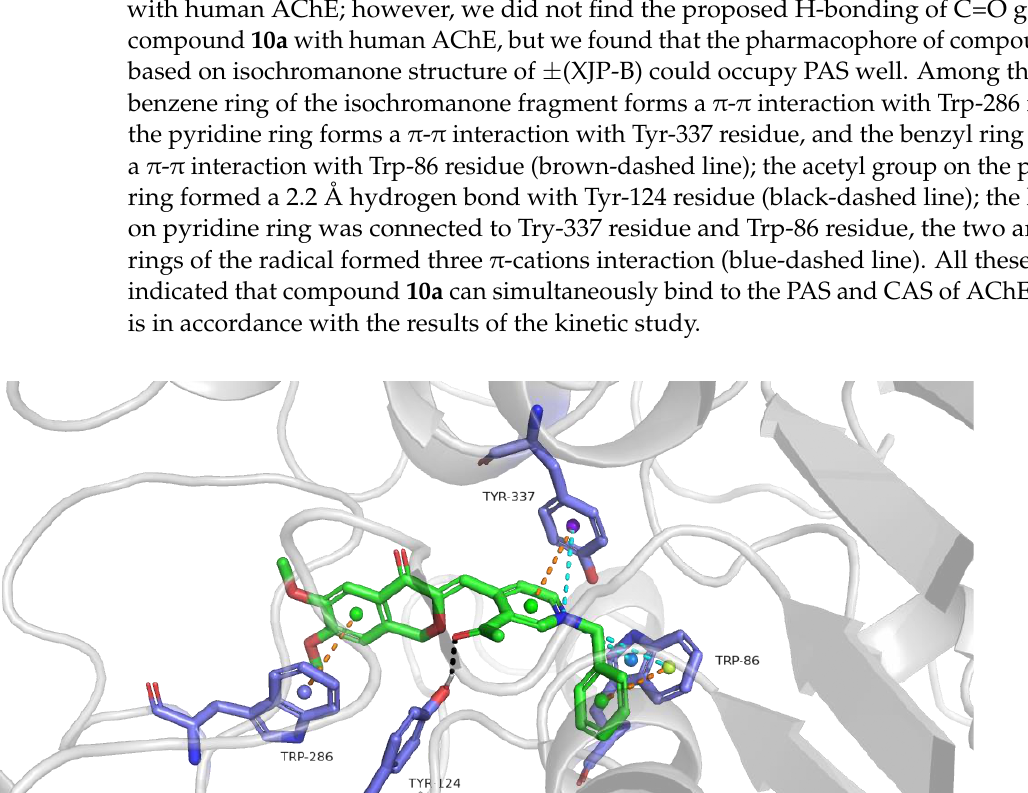
Table 4. ADMET properties and toxicity prediction of selected compounds.